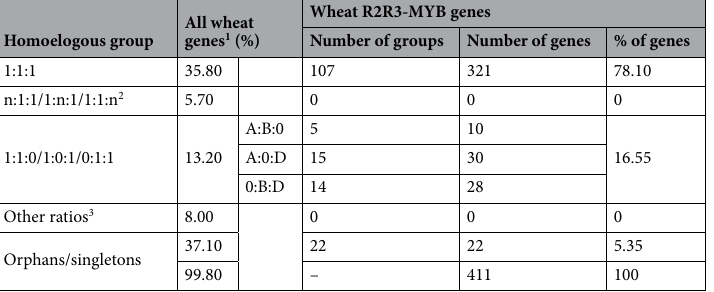
Table 2. Groups of homoeologous R2R3-MYB TFs in wheat. 1 According to IWGSC. 2 For n > 1. 3 E.g. n : 1 : n